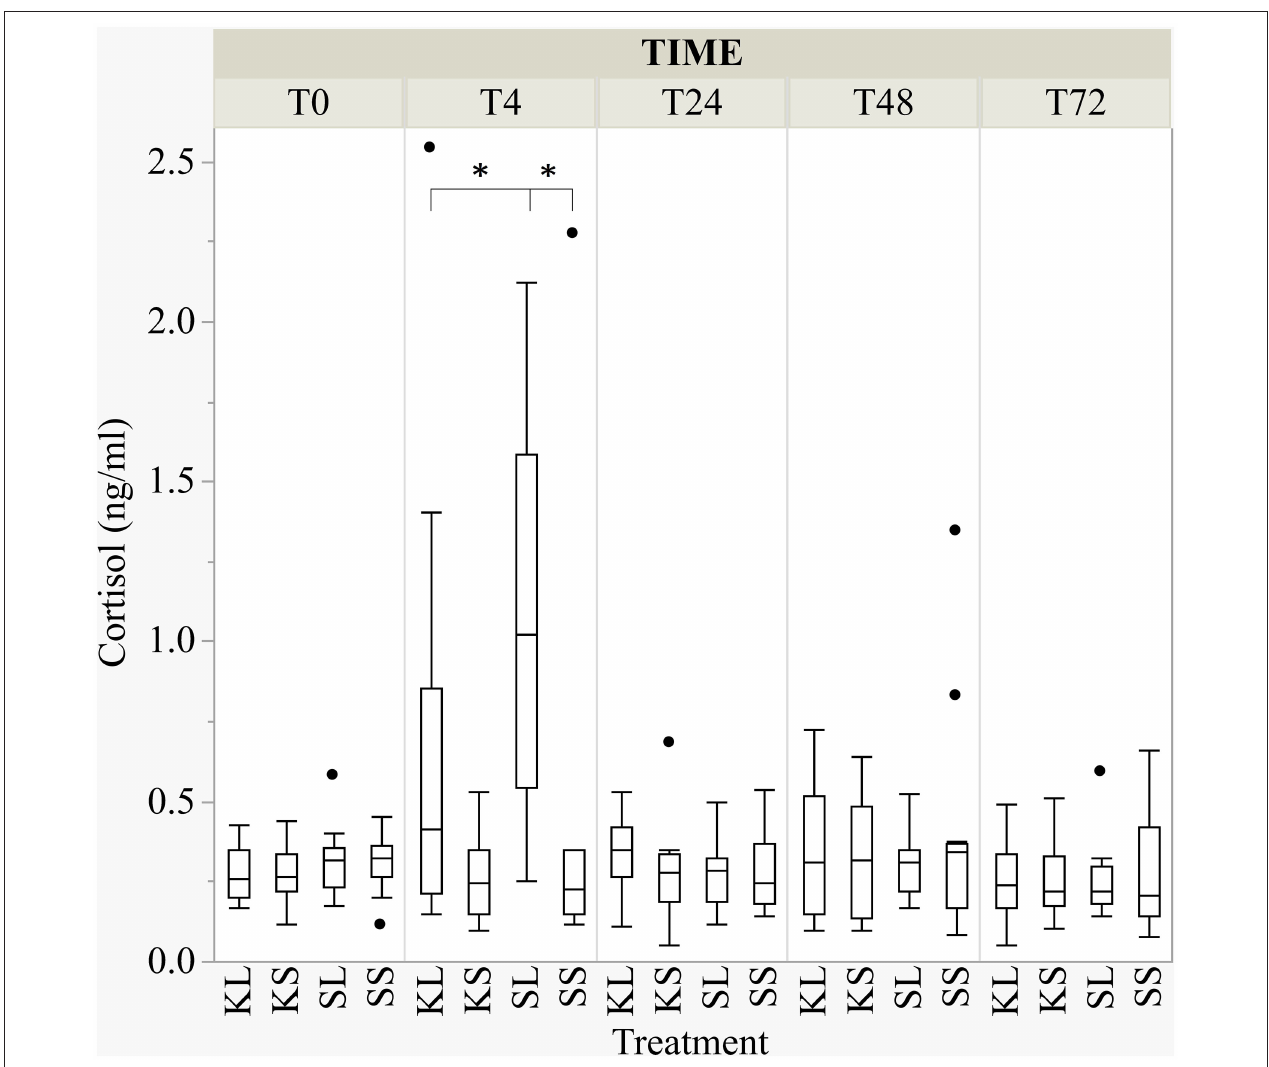
FIGURE 3 | The concentration of salivary cortisol (ng ml − 1 ) at baseline and at 4, 24, 48, and 72h after injecting the pigs with ketoprofen–lipopolysaccharide (LPS), ketoprofen–saline, saline–LPS, and saline–saline. Round dots indicate outliers. Significant differences of planned comparisons between treatments ( p < 0.05) are marked with an